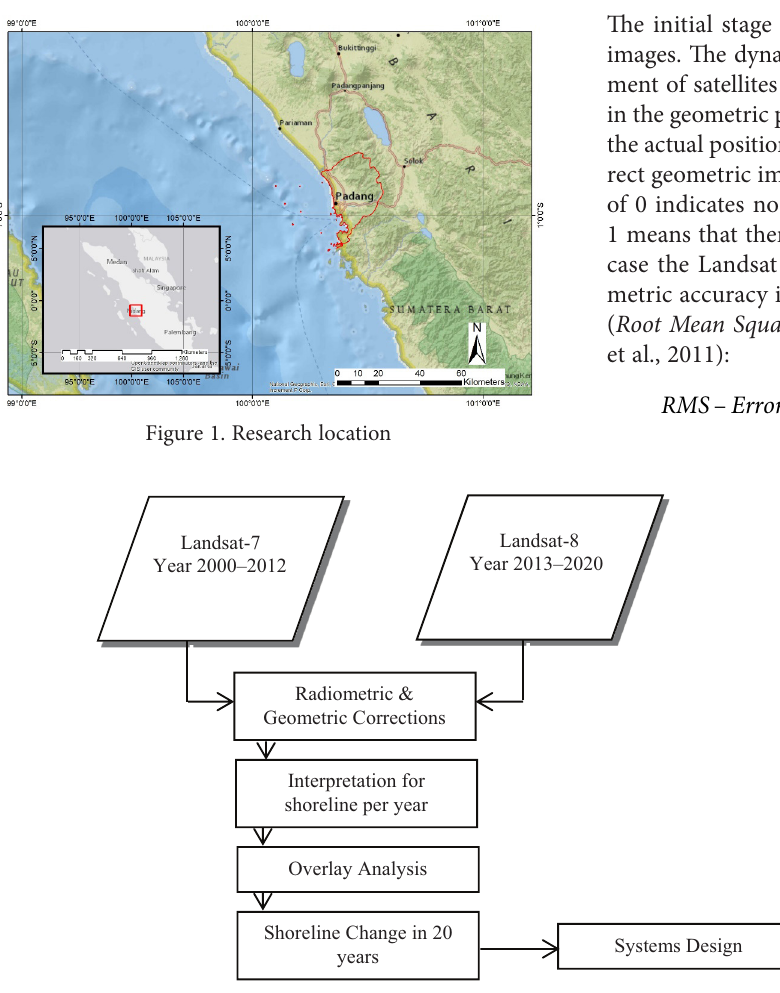
Figure 2. Research